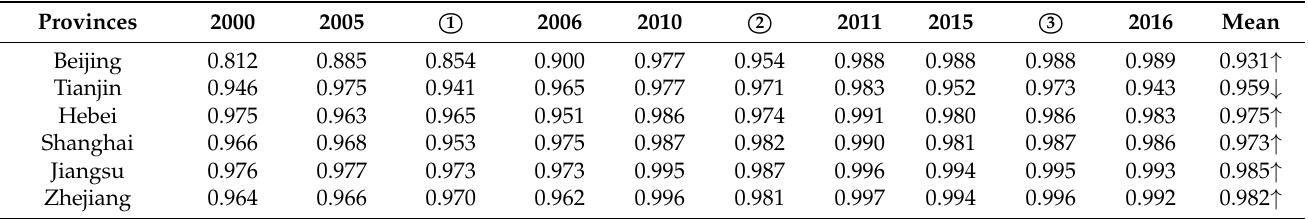
Table 5. The changing trend of China’s energy industrial chain technology efficiency under the influence of factor distortion and carbon dioxide